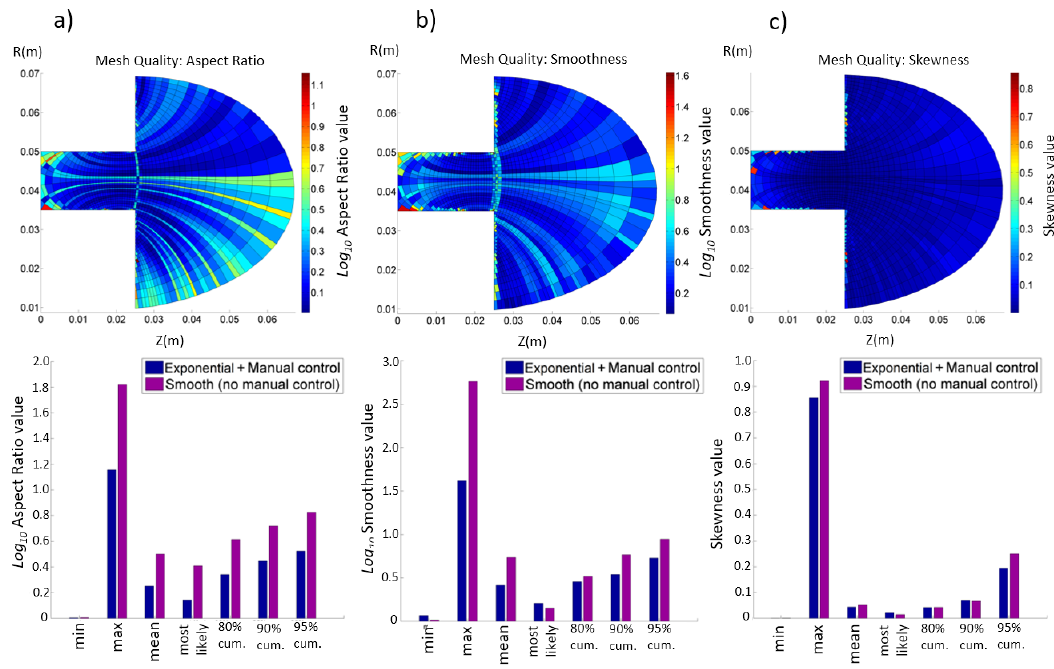
Figure 10. Mesh quality for different meshing examples: ( a ) Aspect Ratios, ( b ) Smoothness, ( c ) Skewness; (top) 2D contours in the mesh and (bottom) Comparison for mesh quality statistics between Exponential-Stretching method mesh presented in Figure 9 and Smoothing method mesh. Diferent values (min., max., mean, most likely, 80% cumulative, 90% cumulative, 95% cumulative) are used for the